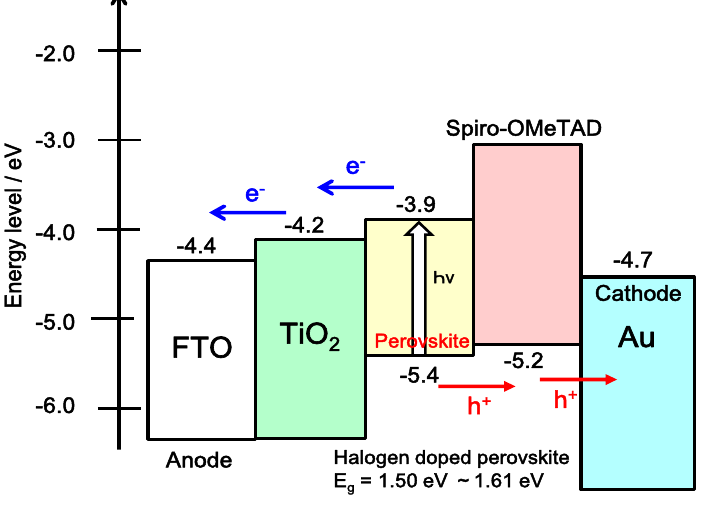
Figure 7. Energy diagram and photovoltaic mechanism of perovskite solar cells.